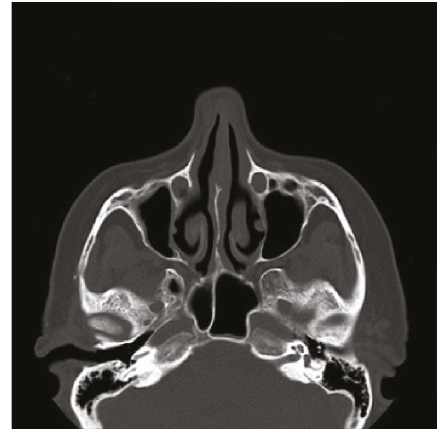
Figure 3: Postoperative axial CT